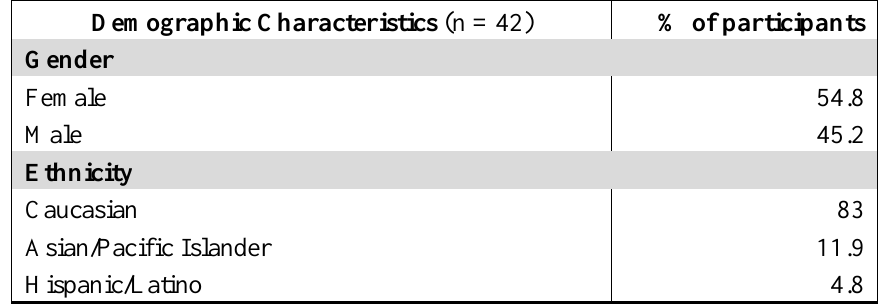
Table 1. Demographic information and campus involvement for college student focus group participants (n =